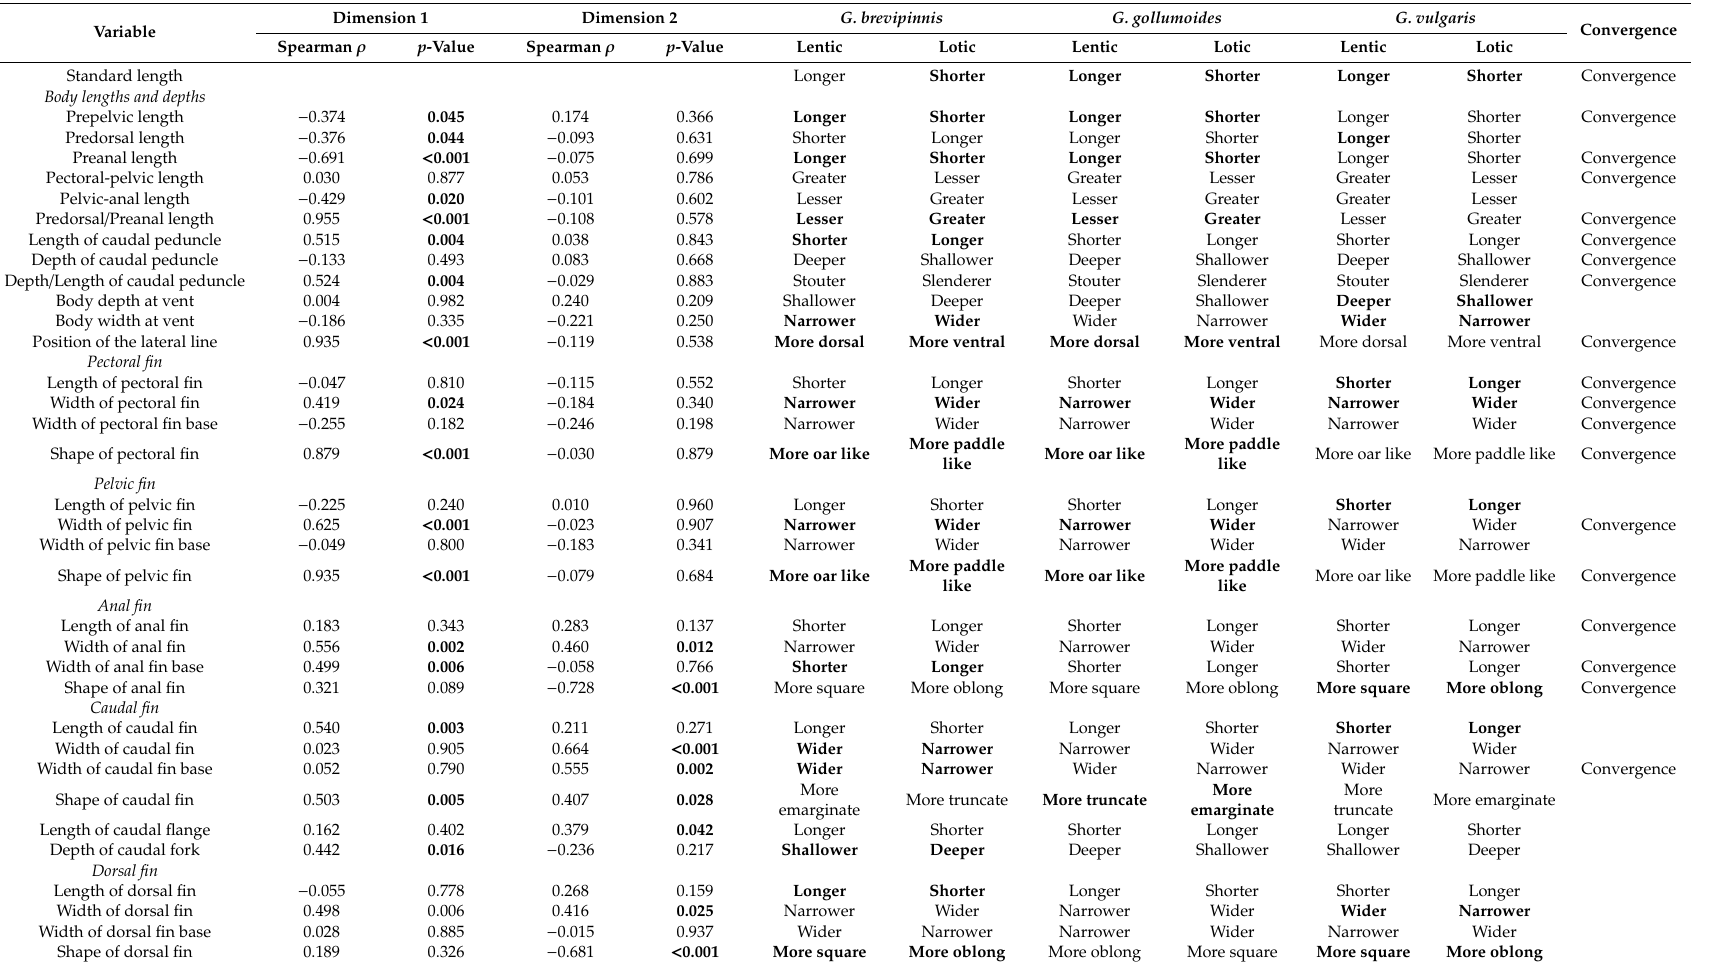
Table 3. Spearman ρ correlations of mean relativised standard length (SL) standardised morphological variables with morphological multidimensional scaling (MDS) dimension 1 and 2 scores, and interpretation of uni-variate ANOVAs on untransformed SL standardised variables within lentic and lotic habitats for each Galaxias species. Bold text—significant at p <